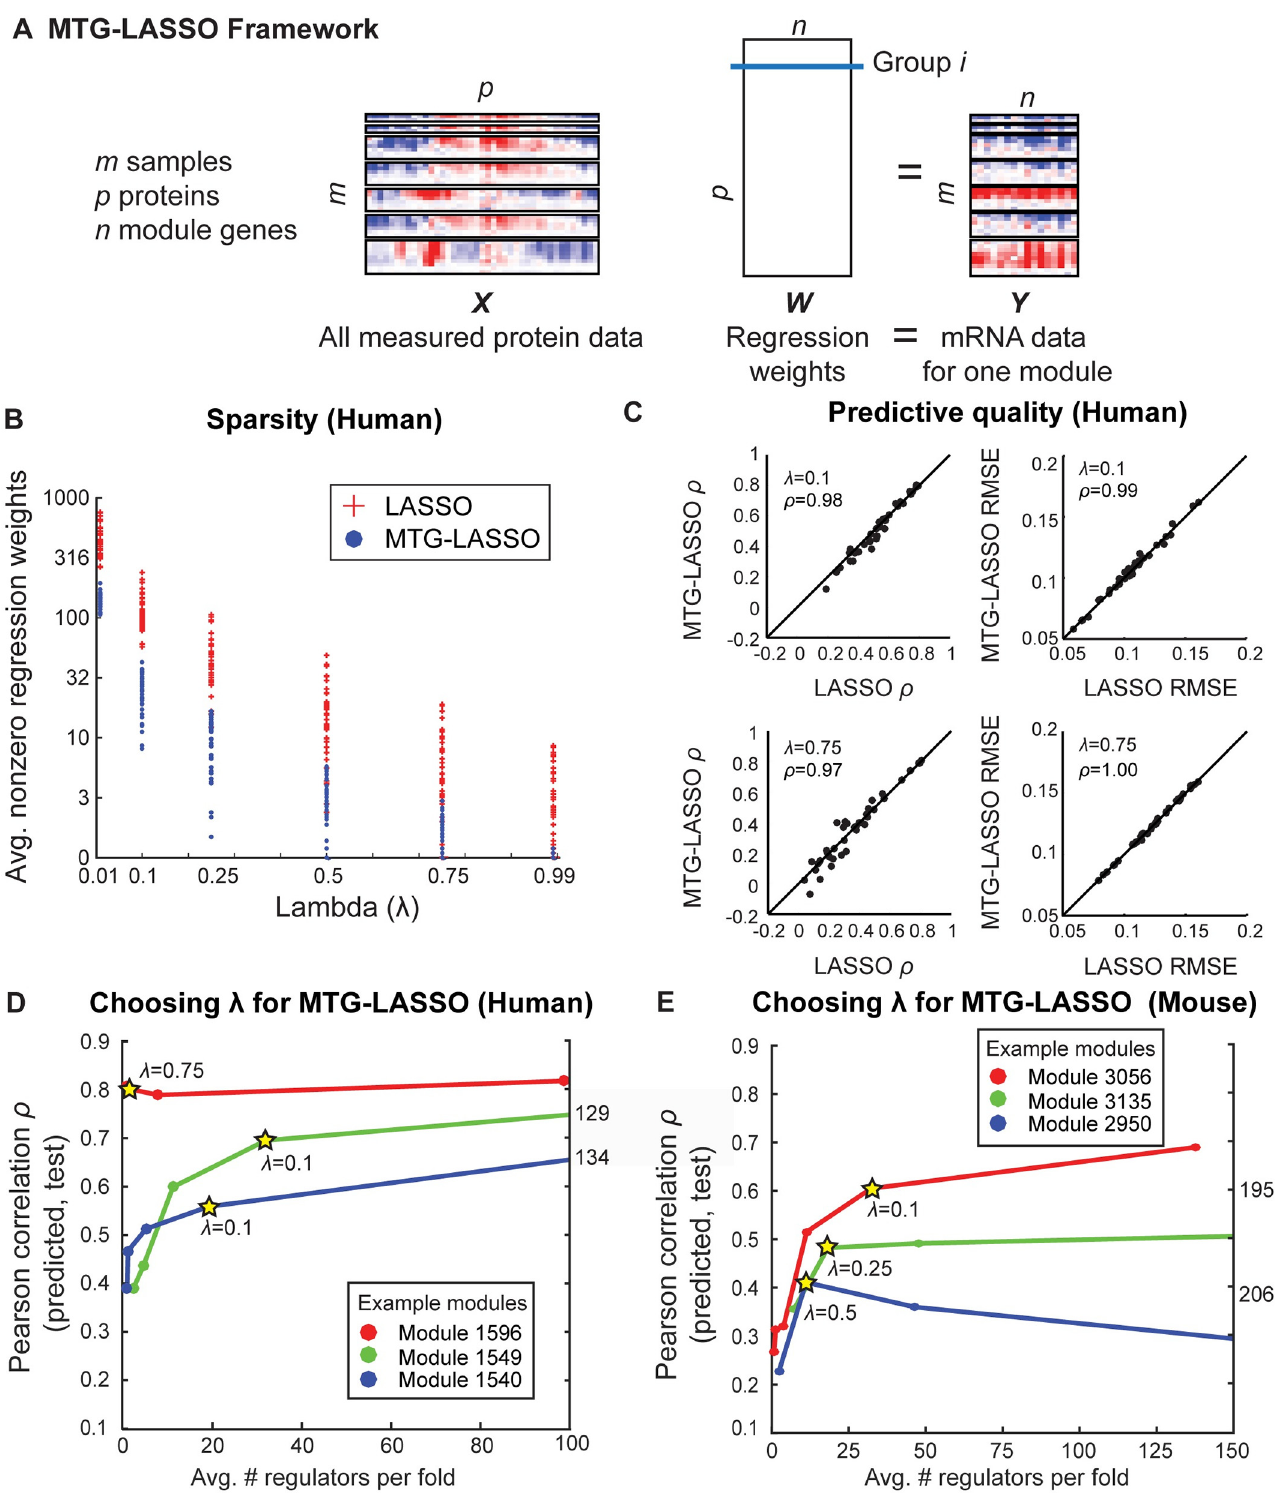
Fig 5. Multi-task Group LASSO (MTG-LASSO) structured-sparsity approach for integration of protein data with expression-based regulatory module networks. A. Illustration of MTG-LASSO framework for predicting protein regulators for one module ( Methods ). Horizontal separations in the X and Y data boxes represent different virus time course. Rows of X and Y represent time points. Columns of X correspond to